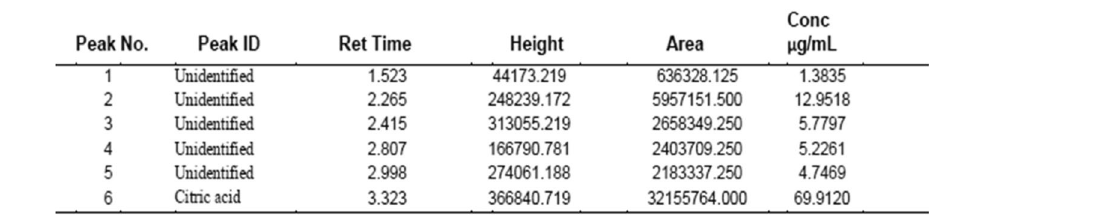
Table 2 Quantification of citric acid produced using